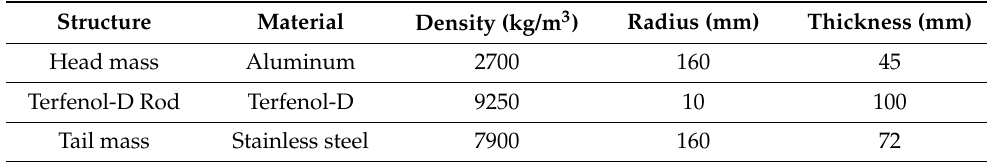
Table 1. Structural parameters of the transducer.